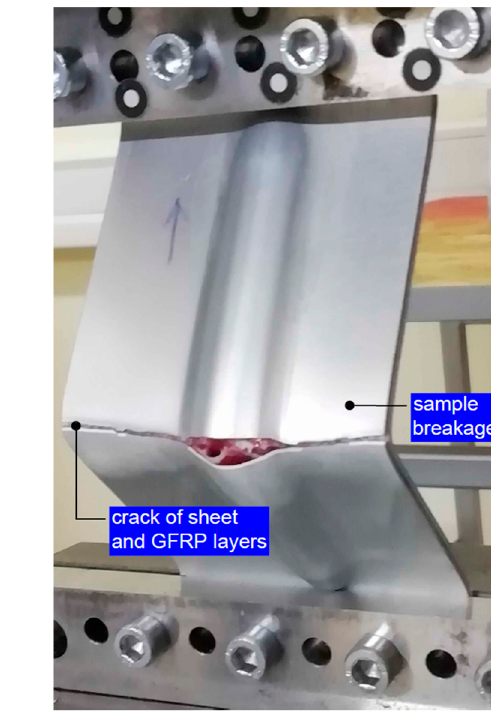
20 of 23 Figure 24. Force–displacement curves obtained from the uniaxial compression test of panels. Based on pictures of the damaged samples (Figure 25), the fracture mechanisms resulting from the geometry of the individual samples can be revealed. Specimens without rib-stiffening were bent